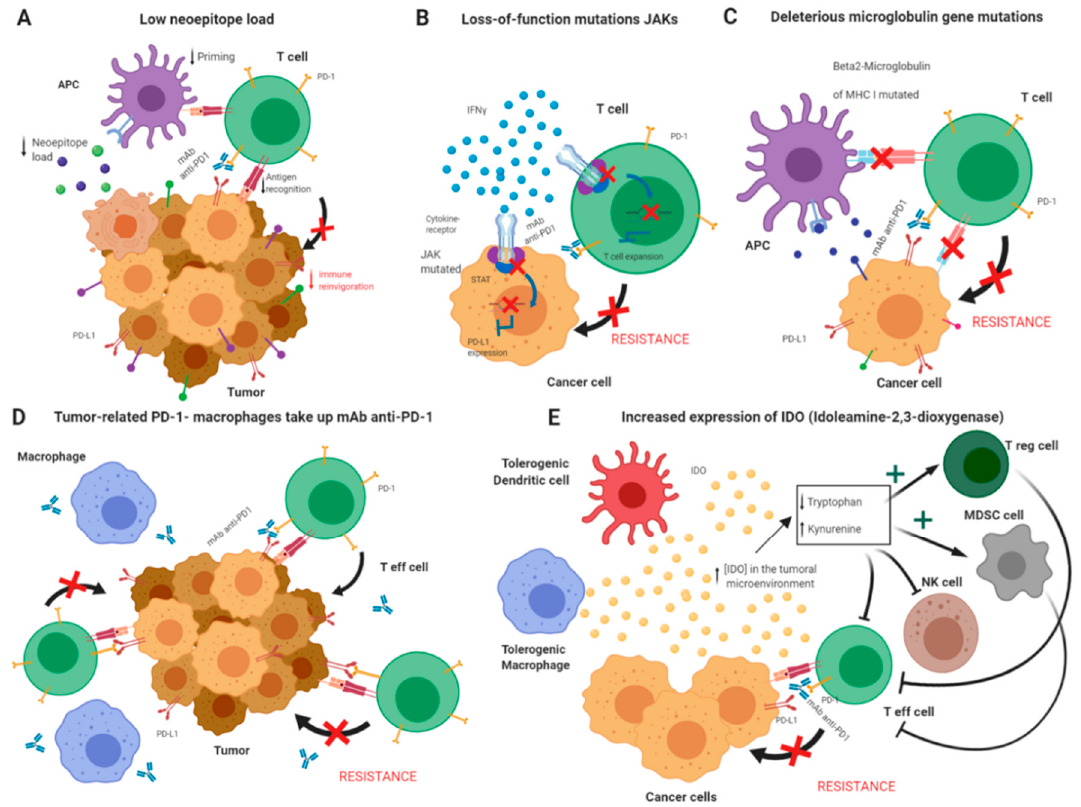
Figure 1. Representative mechanisms of resistance to anti-PD-1 immune checkpoint blockade. ( A ) A low epitope load in the tumor cells normally drives to a minimal immune reinvigoration due to a lower capacity of antigen presenting cells (APC) to present antigen to T cells (low priming) and a lower cytotoxic T cell recognition of the tumor cell antigen. ( B ) Loss-of-function mutations of Janus kinase (JAKs) desensitize the T cells to the IFN- γ exposure and dramatically decrease the expression level of PD-L1 through lack of activation of the transcription factor STAT. This decrease in PD-L1 leads to both primary and acquired resistance of PD-1 blockade therapy, given that the reinvigoration capacity of T cell through reactivation of the PD-1 / PD-L1 axis is abrogated. ( C ) Deleterious mutations in the gene encoding β 2 microglobulin (an MHC class I subunit) lead to loss of antigen presentation, producing resistance to anti-PD-1 drugs. ( D ) The propensity of the tumor-related PD-1 macrophages to take up anti-PD-1 monoclonal antibodies causes the capture of the anti-PD-1 antibody even from the surface of the PD-1 + CD8 + T cells that already bound the drug. This impedes or reverts the anti-PD-1 / PD-1 interaction at the cytotoxic T cell provoking resistance to the treatment. ( E ) In the “escape” phase of the tumor immunoediting, when the tumor is clinically manifested, tolerogenic dendritic cells, myeloid-derived suppressor cells (MDSCs), and tumor-associated macrophages secrete indoleamine-2,3-dioxygenase (IDO), which decreases tryptophan and increases kynurenine. These molecules inhibit effector T cells and NK functions and stimulate regulatory T cells, provoking immunosuppression and enhancing the tolerogenicity of macrophages and dendritic cells. IDO1 also enhances the expansion and activation of MDSCs. All previous alterations suppress the activity of anti-tumor effector T cells.